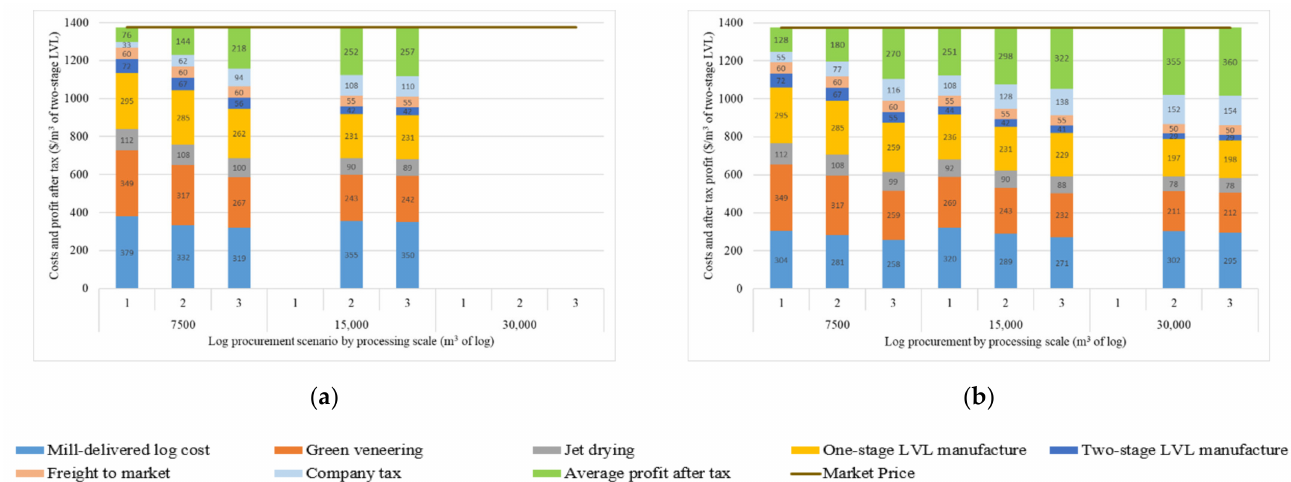
Figure 5. Average costs of production and profit after tax for integrated production of two-stage